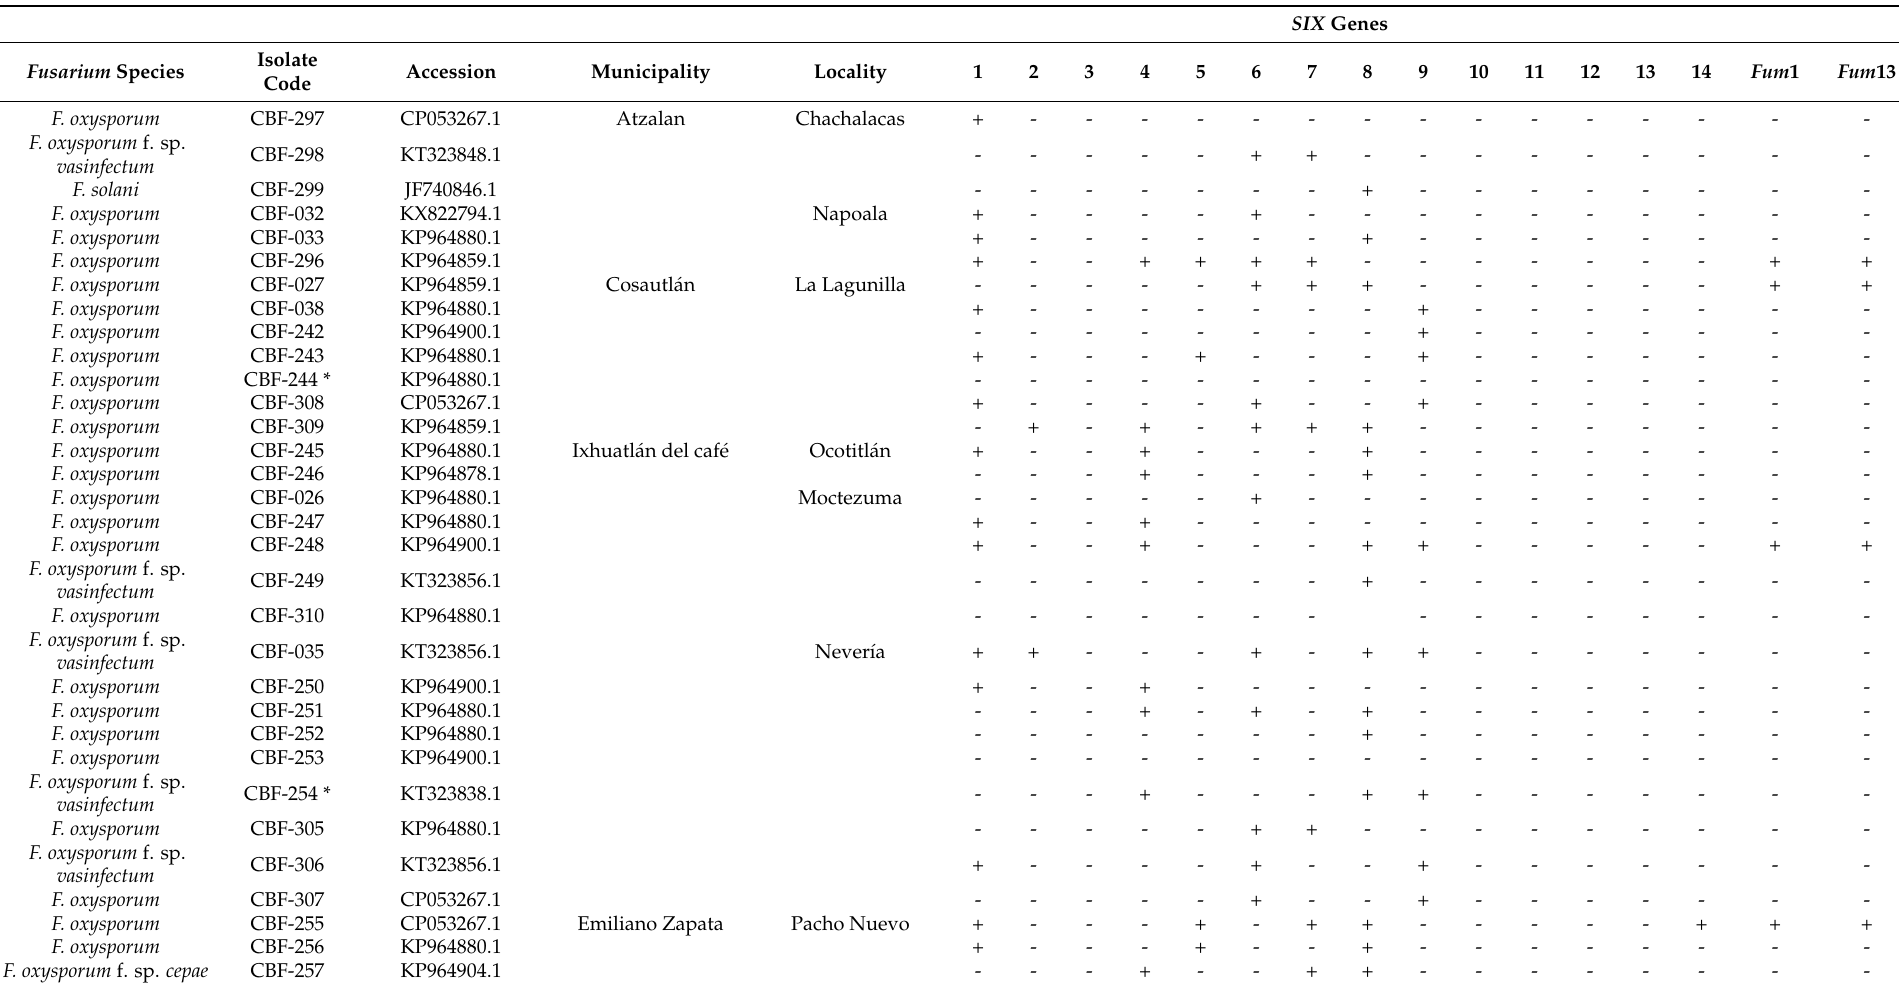
Table 1. PCR screening targeting pathogenicity SIX1 - SIX14 genes, and two toxigenicity genes ( Fum1 and Fum13 ) for detection of putative fumonisin producing Fusarium isolates.